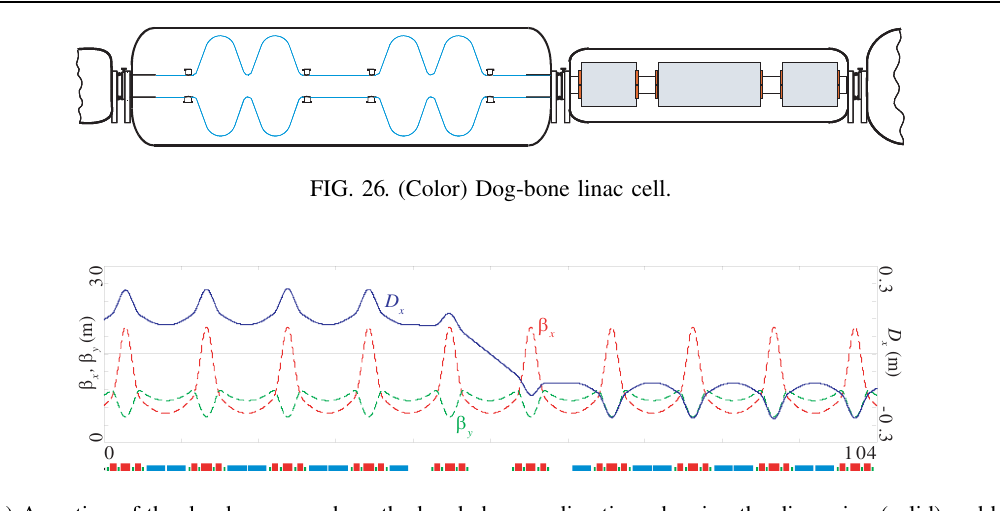
FIG. 27. (Color) A section of the dog-bone arc where the bend changes direction, showing the dispersion (solid) and beta functions (dashed).